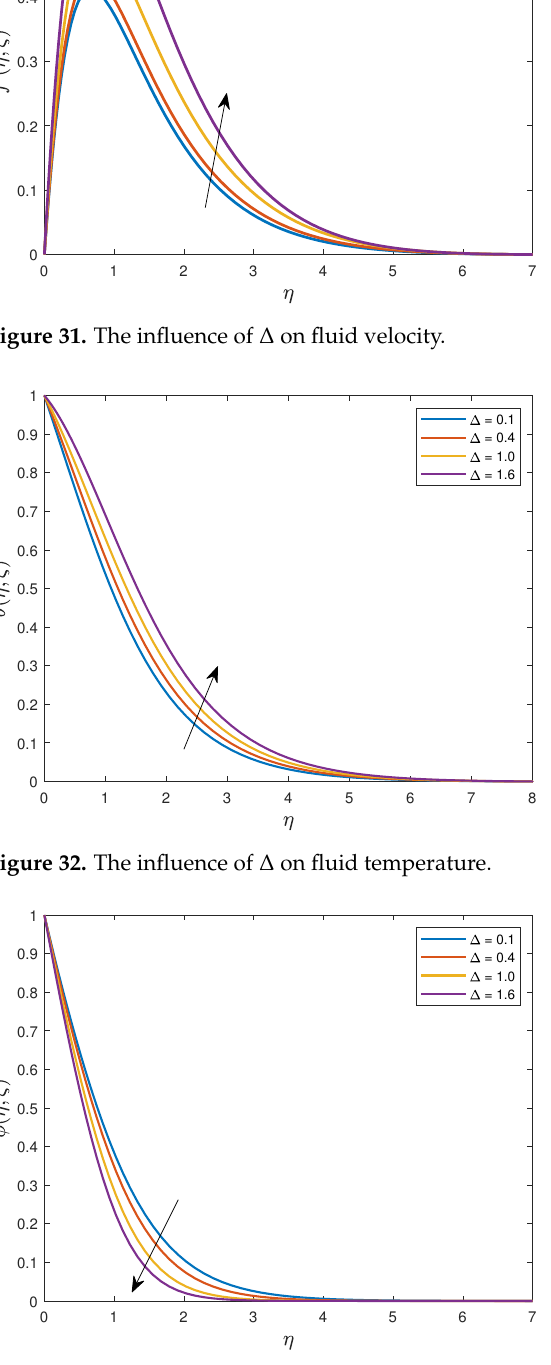
Figure 33. The influence of ∆ on fluid